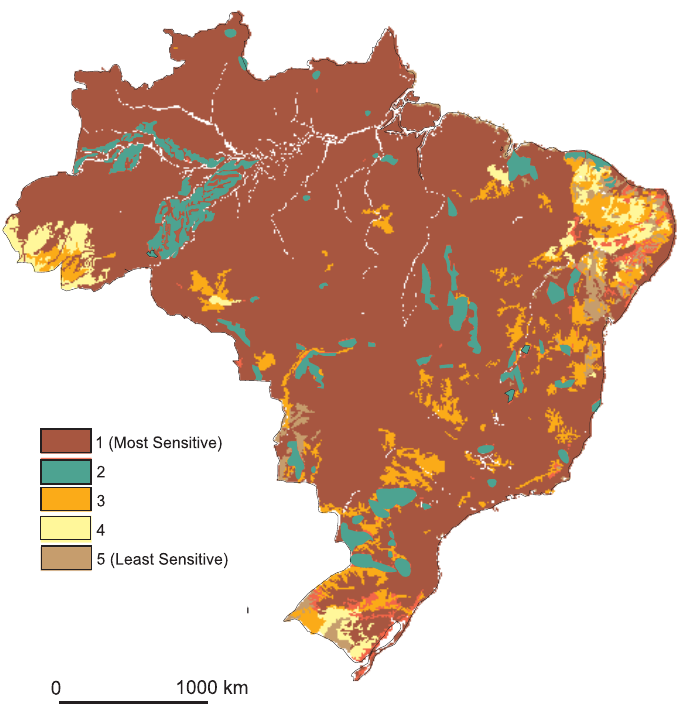
Fig. 4 – Distribution of ecosystem sensitivy to acidic deposition in